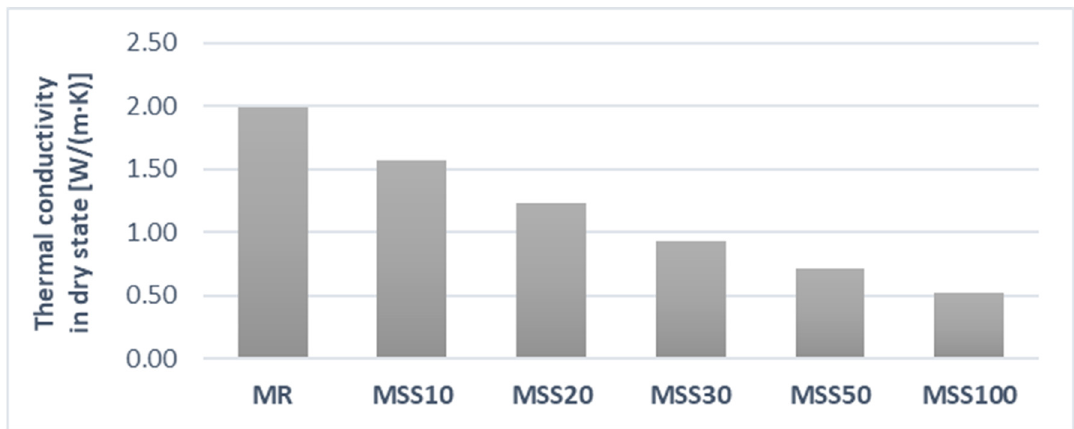
Figure 13. Thermal conductivity in dry state of studied mortars.